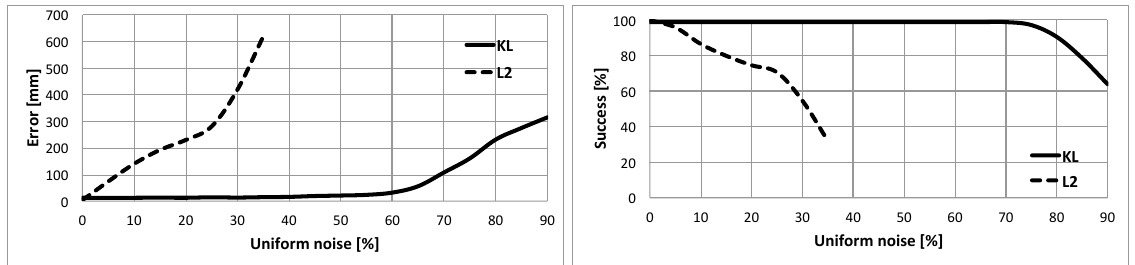
Figure 8. ( Left ) GL error vs . uniform noise (percentage of contaminated measurements); ( Right ) success vs . uniform